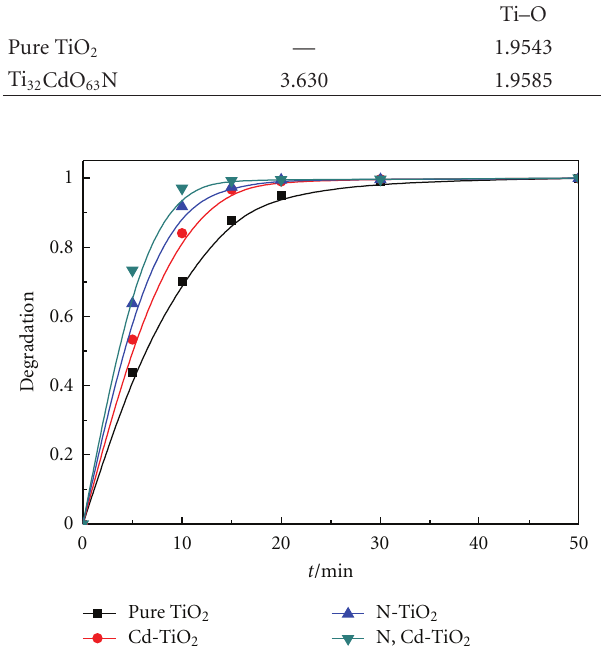
Figure 5: Photocatalytic degradation of MO by photocatalysts.